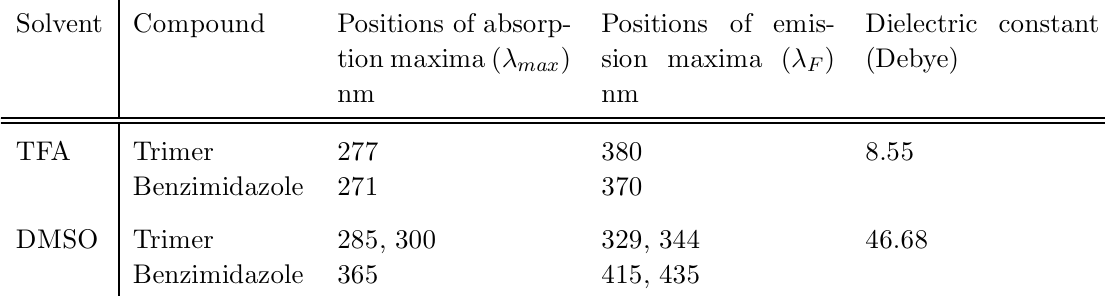
Table 1 Absorption and emission data of the trimer and benzimidazole in two di¬erent media (DMSO and TFA) at